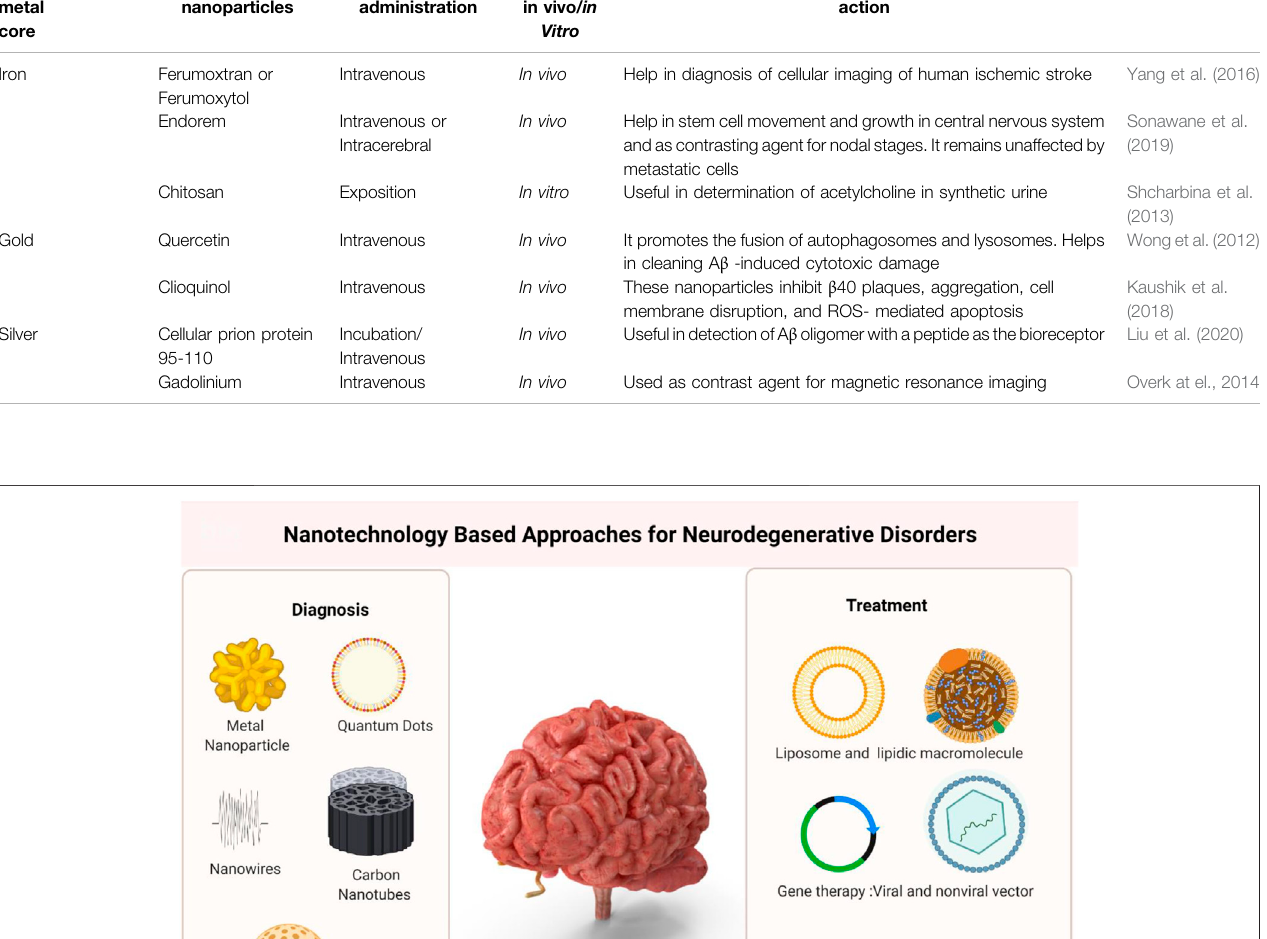
TABLE 1 | Summarization of different metal core nanomaterials for different functions in Neurological diagnostics. Nanomaterial metal